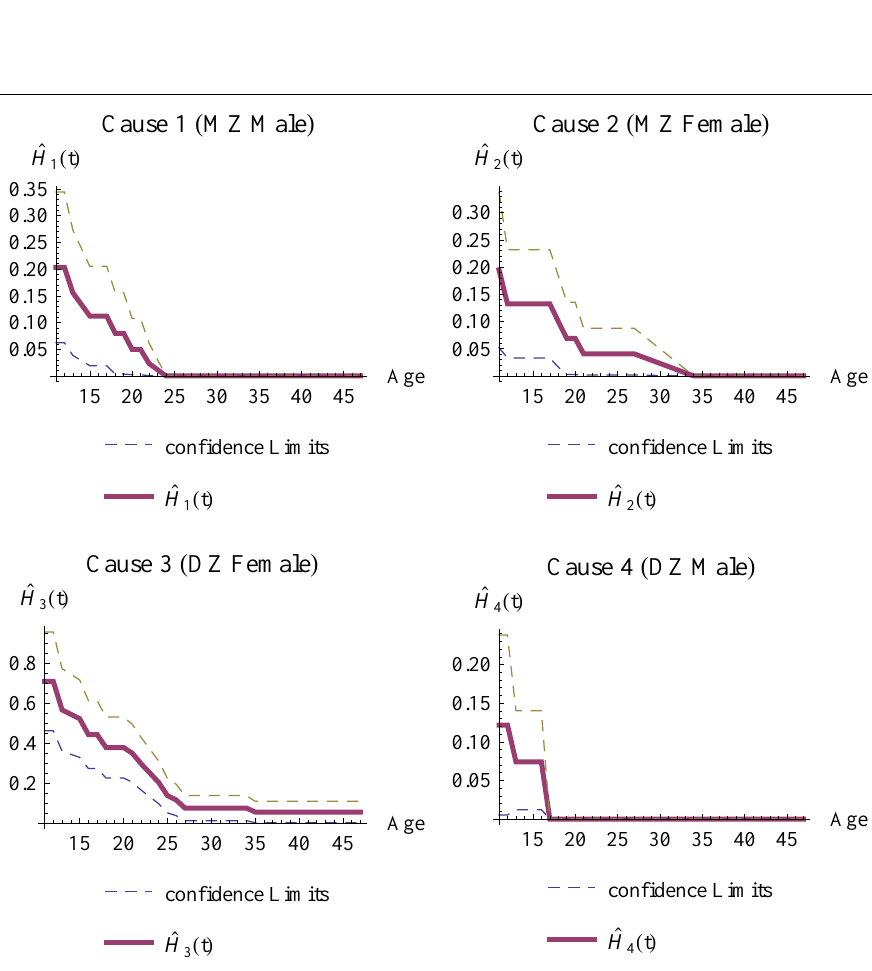
Figure 2 { Plot of estimate of H j ( t ); j = 1 , 2 , 3 , 4 for Australian twin